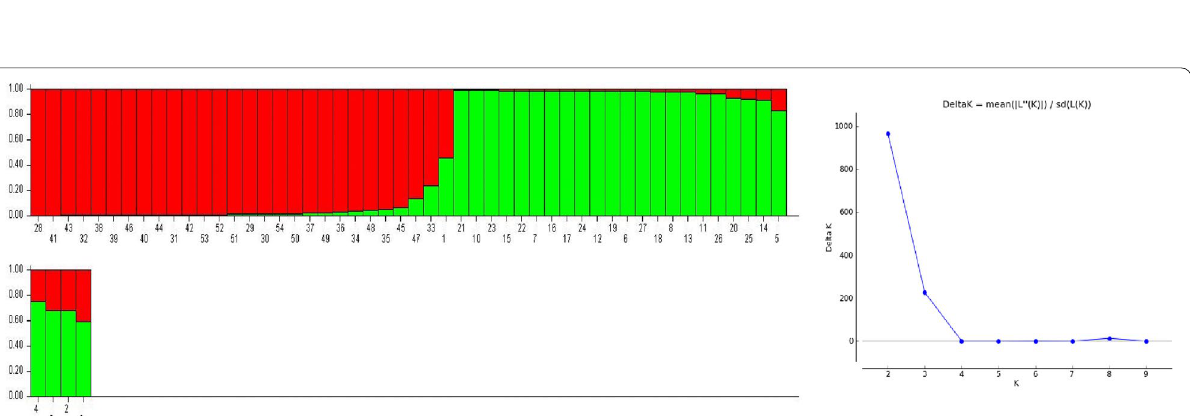
Fig. 9 Inferred population structure of 54 Capsicum accessions based on ISSR markers using STRU CTU RE program which observed at K maximum value of ΔK was determined at K